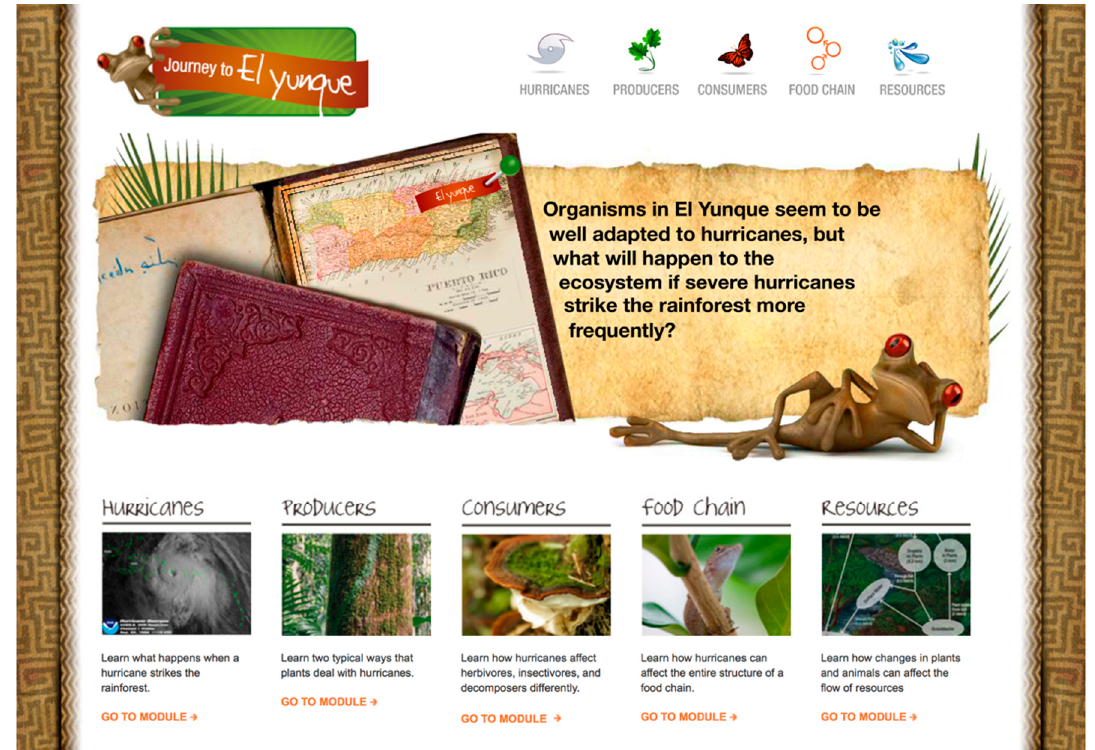
Figure 1. Screenshot of the main page of Journey to El Yunque.